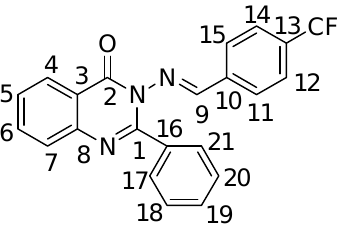
Figure 1 . The structure and carbon atom numbering of compound III-3